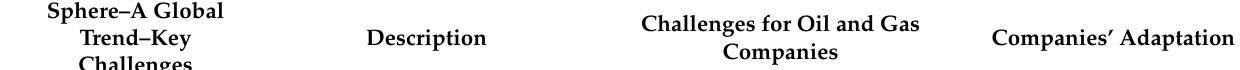
Table A1. Global trends, challenges, and approaches that oil and gas companies can take to adapt to a new